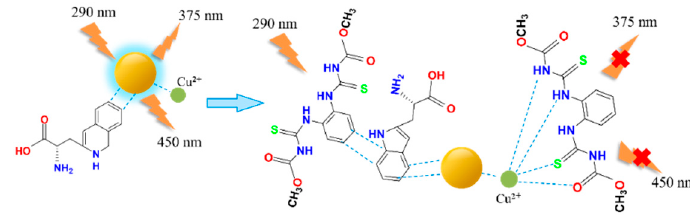
Figure 2. TM detection using Cu-CDs.